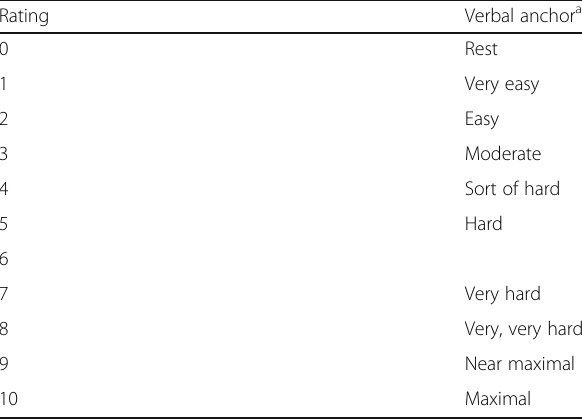
Table 1 Session Rating of Perceived Exertion (sRPE)